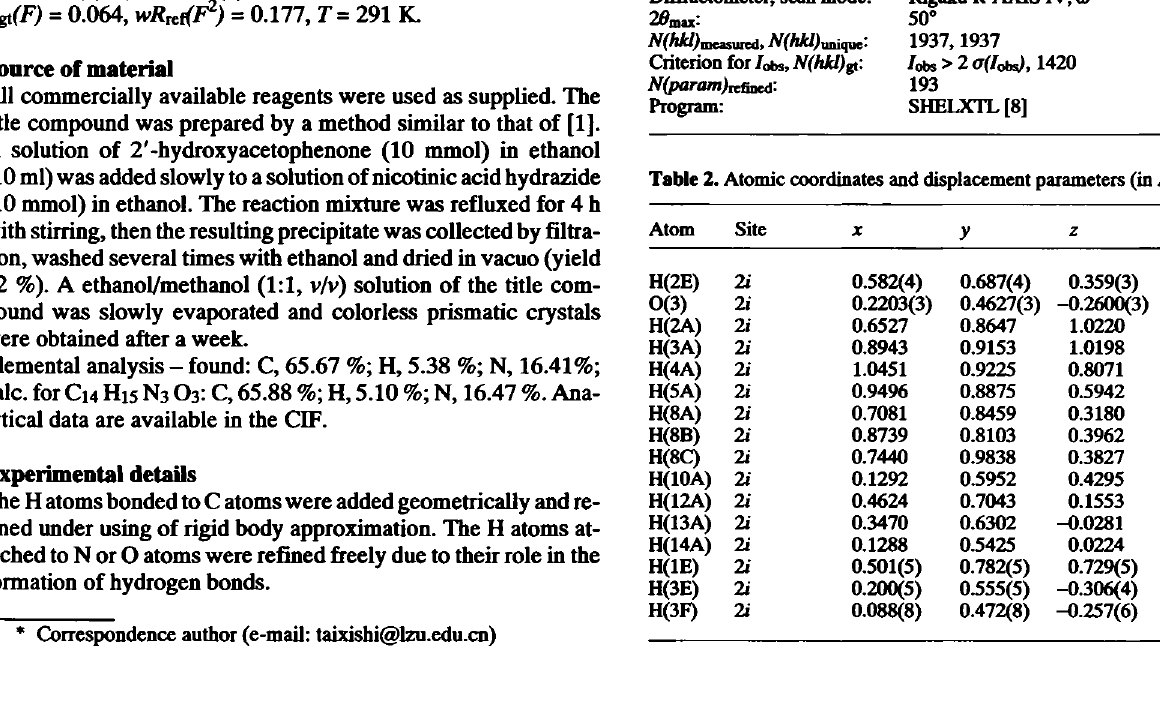
Table 1. Data collection and handling.